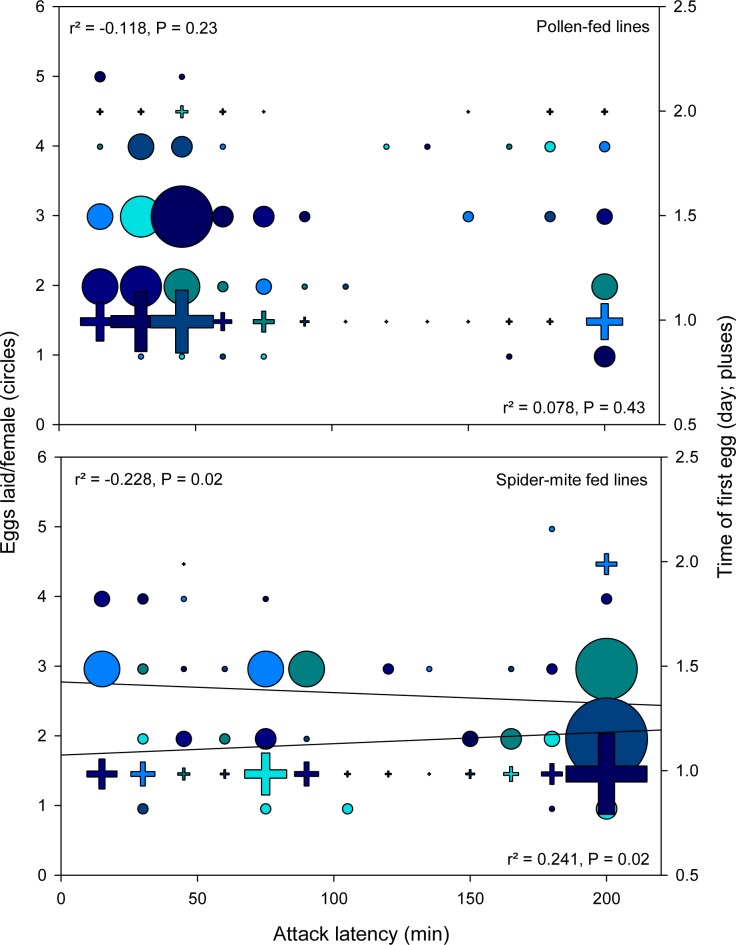
Correlation analyses (experiment 1).Total number of eggs (circles) and time of first egg (pluses) regressed on attack latency of Amblyseius swirskii females from the pollen- and spider mite-reared lines (Koppert and Israel populations lumped). Symbol size is proportional to sample size. Statistical results refer to bivariate linear regressions.